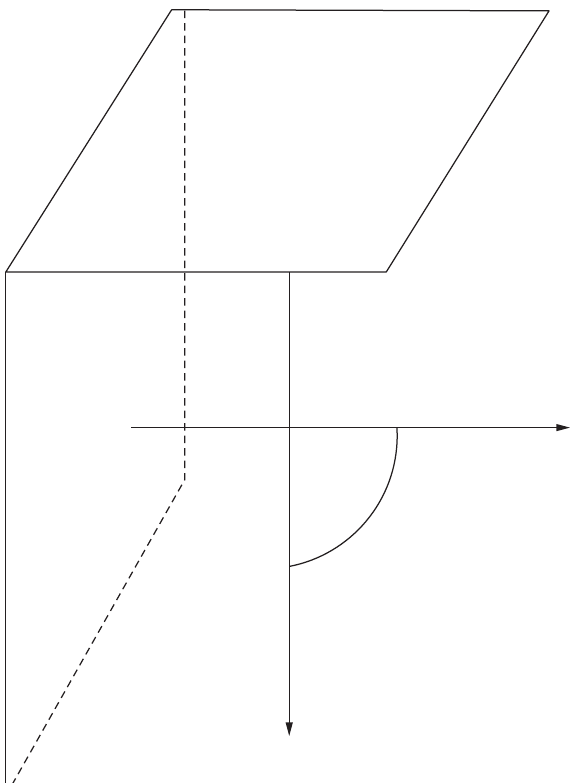
Figure 5: The concept of edge compatibility.